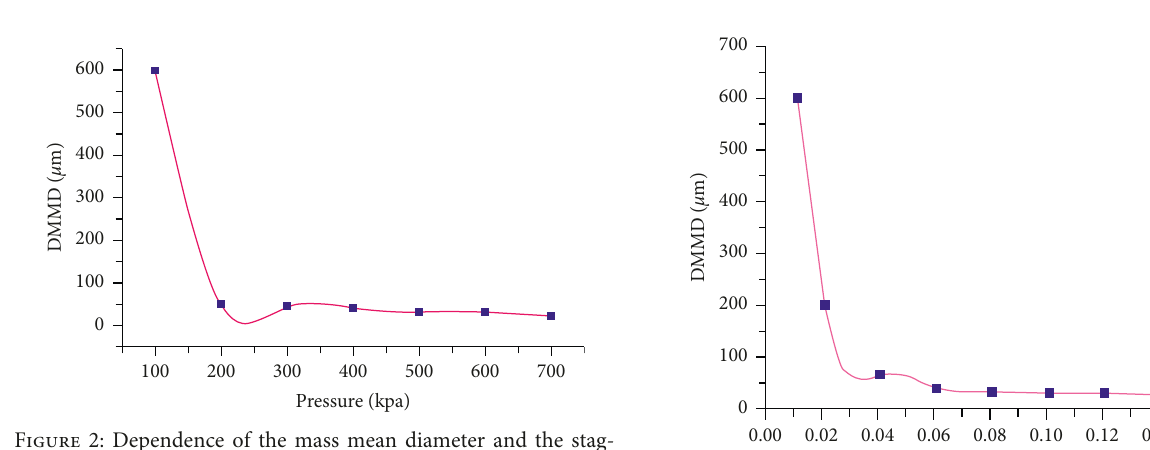
Figure 1: Isometric view of air at 300kPa with the flow of fuel of 0.18g/s. The values needed to evaluate the Wigg equation were taken from the tables predetermined by the software V 1.451423 (cSt). m F : 0.20 (g/s); h: 0.040 (cm); σ : 22.3 (dynes/cm).